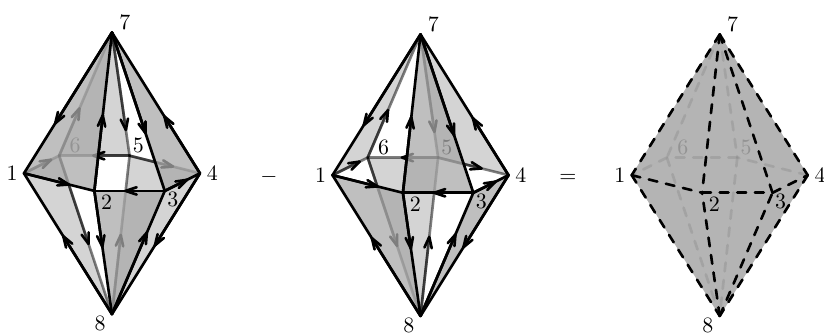
Figure 5 . Sphere move between (3.17) and (3.18) for n =8. The corresponding sets of triples are T 1 = f (1 ; 2 ; 7) ; (3 ; 4 ; 7) ; (5 ; 6 ; 7) ; (3 ; 2 ; 8) ; (5 ; 4 ; 8) ; (1 ; 6 ; 8) g and T 2 = f (3 ; 2 ; 7) ; (5 ; 4 ; 7) ; (1 ; 6 ; 7) ; (1 ; 2 ; 8) ; (3 ; 4 ; 8) ; (5 ; 6 ; 8) g .